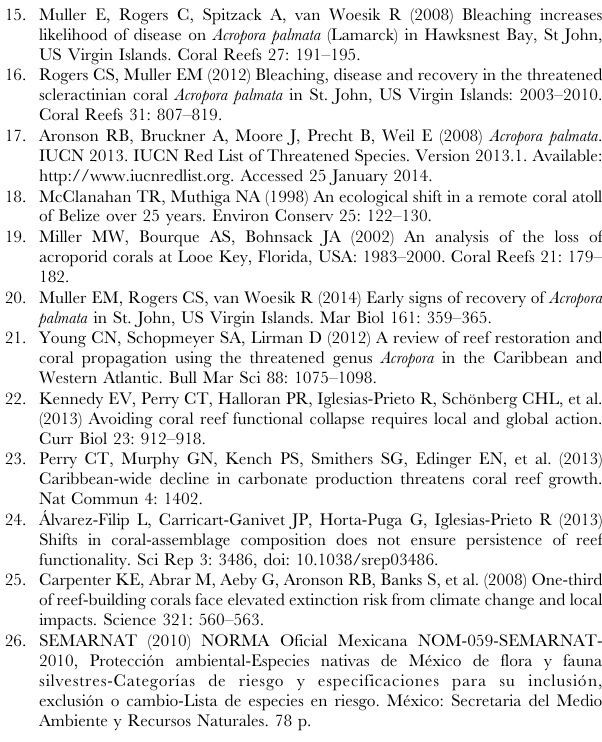
Figure S1 Location of the reef sites surveyed in 1985 and 2010–12 along the Mexican Caribbean